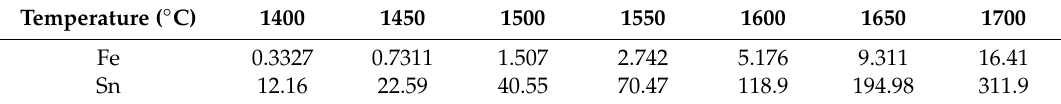
Table 3. Saturated vapor pressures of pure iron and tin at di ff erent temperatures, Pa